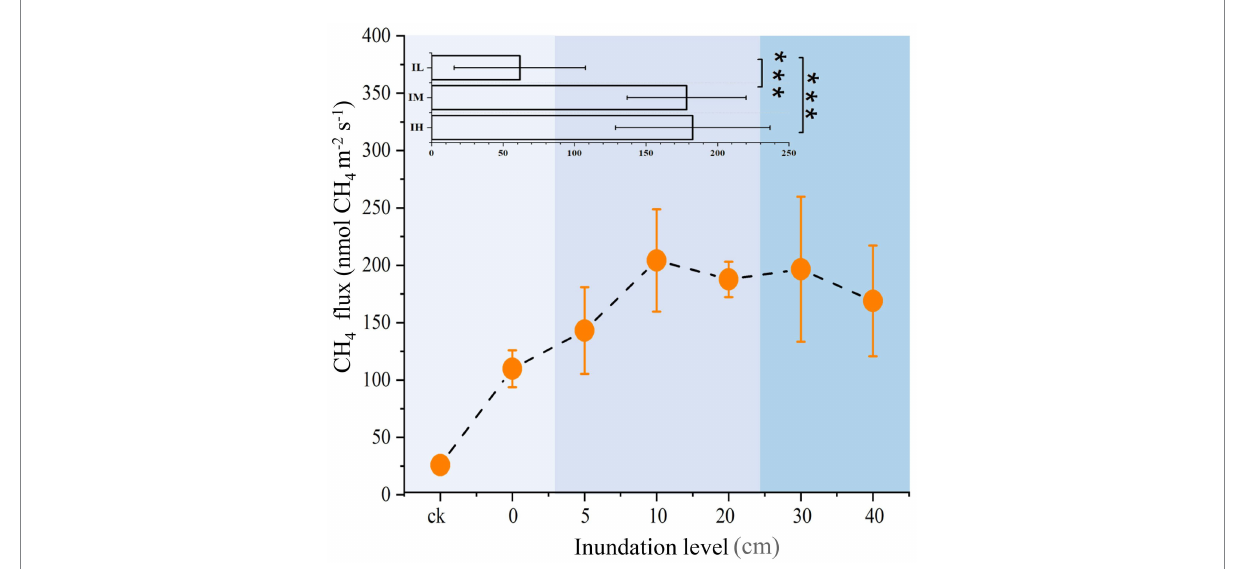
FIGURE 1 Variations in CH 4 fluxes at different inundation depths (means ± SE, n = 27). In insets, inundation depths in soil were subjected to three treatments: Soils were exposed to low inundation (IL, n = 7), moderate inundation (IM, n = 12) and high inundation (IH, n = 8). One-way analysis of variance (ANOVA) of three groups was performed. For all panels, the extent of blue backgrounds indicates the three groups. *** p <